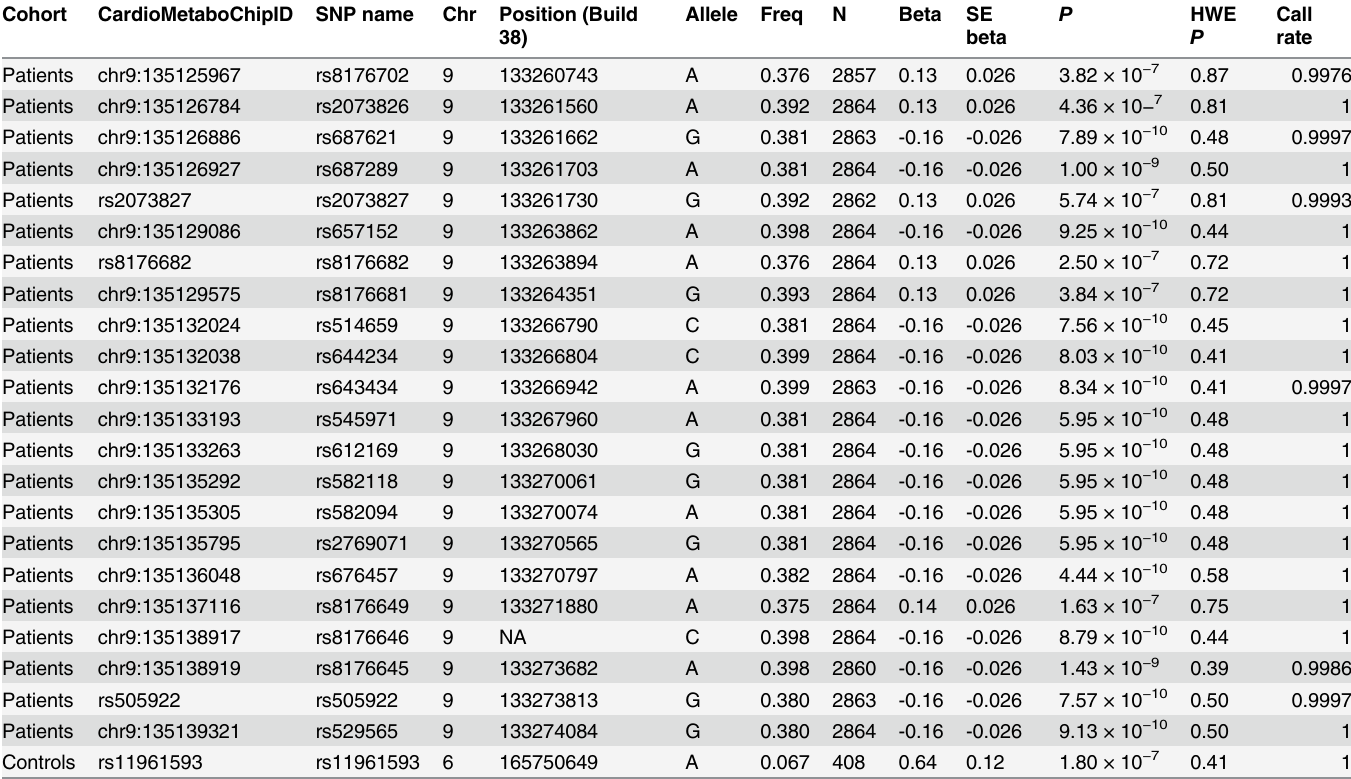
Table 4. Genome-wide significant SNPs associated with a variation in IL-10 levels.